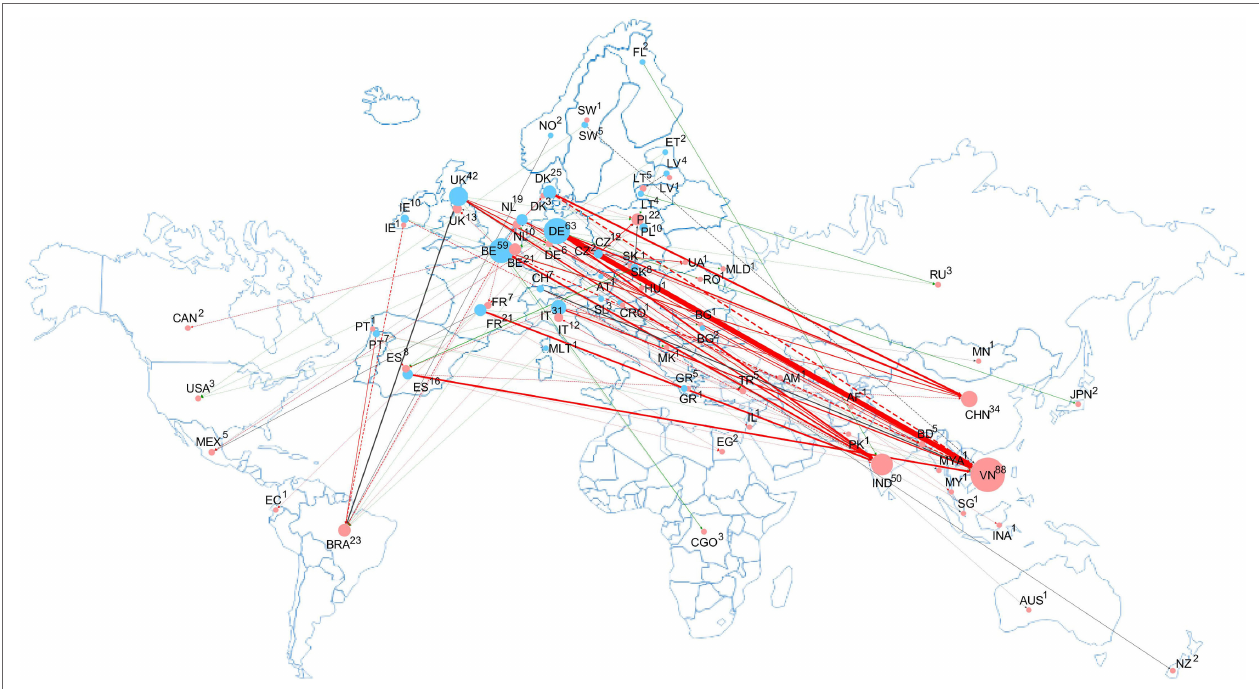
FiGURe 4 | Connection network among notifier and consigner countries in the Rapid Alert System for Food and Feed database regarding food/feed contamination with veterinary drug residues between 2012 and 2016. Notifier and consigner countries are designated with blue and red circles, respectively, with the number of reported cases indicated near the country code and circle sizes proportional with numbers of reported cases. Thicknesses of the connecting lines (dashed line for single and solid line for multiple case notifications) are proportional with overall notification cases in the given relation, and colors of the connecting lines corresponding to the risk assessment category of the contamination cases found (red: severe cases were identified; gray: no severe cases, but cases of undecided severity were identified; and green: solely non-severe cases were identified). (Note that Europe is shown larger than proportional on the background world map for better connectivity